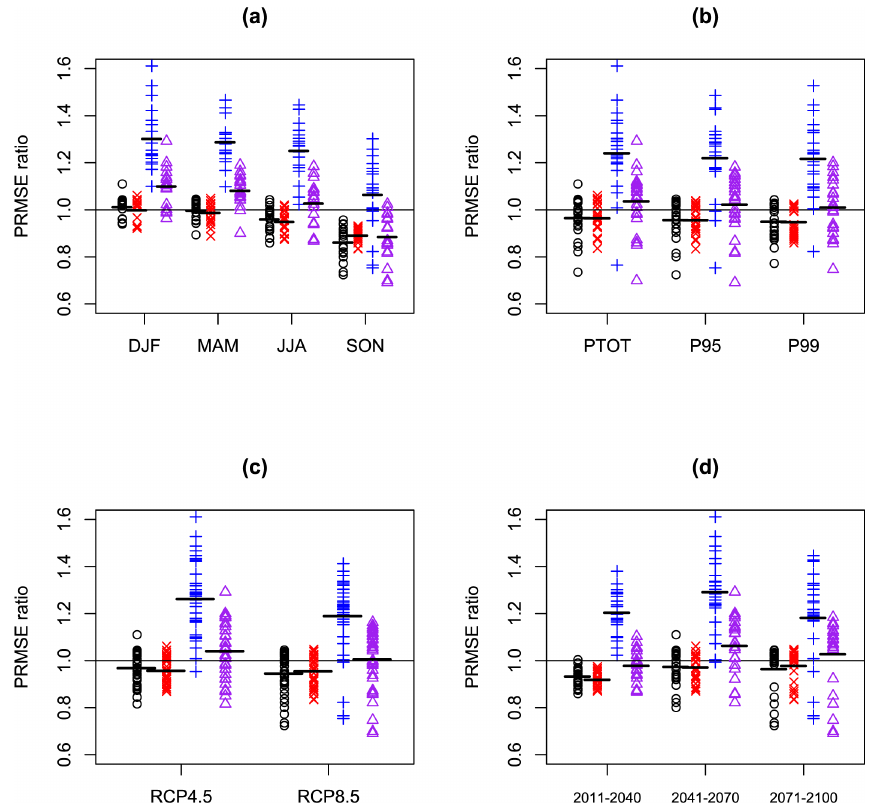
Figure 7. Each panel shows 72 values of the PRMSE ratio from the SPMA scheme (black circles), 72 values of the PRMSE ratio from the BPMA scheme (red Xs), 72 values of the PRMSE ratio from significance testing (blue crosses), and 72 values of the PRMSE ratio from the AICMA scheme (purple triangles), all derived from the 72 EURO-CORDEX climate change projections described in the text, along with means within each sub-set (horizontal lines). Panel (a) shows the 72 values as a function of season, panel (b) shows them as a function of rainfall variable, panel (c) shows them as a function of RCP, and panel (d) shows them as a function of time